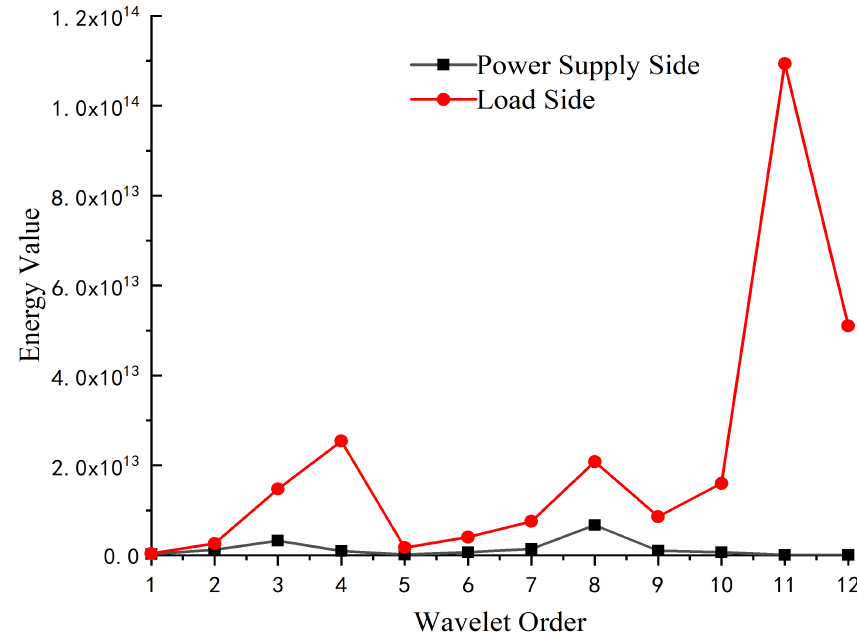
Figure 9. Wavelet energy values of VFTO at power side and load side. 4.3. Comparison with Power Frequency AC Voltage and Other Overvoltages Wavelet decomposition and SVD were used on a 550 kV power frequency AC voltage waveform to extract the wavelet coefficients of each frequency layer and calculate the wavelet energy values of each order. The results are shown in Figure